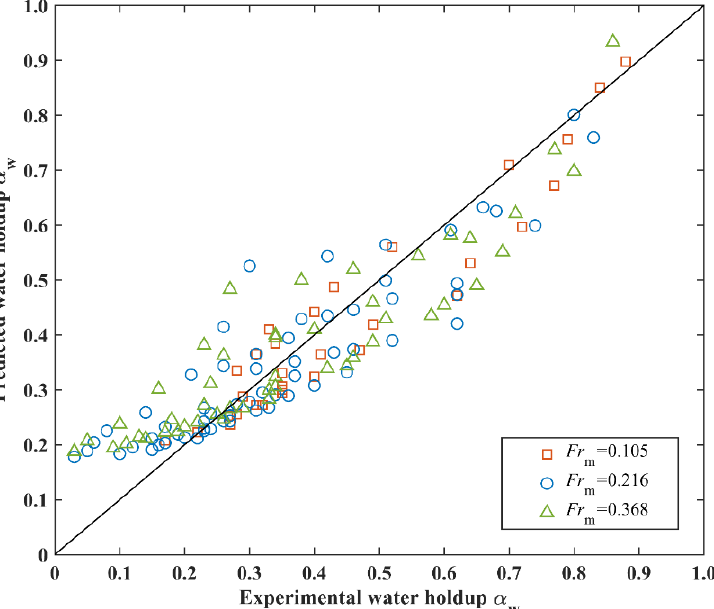
Figure 12. Comparison between the predicted water holdup and the experimental data for the oil – water – gas three-phase flow. The input water cut ε w ranged from 10% to 90%. The brown squares corresponded to Fr m = 0.105, the blue circles corresponded to Fr m = 0.216, and the green triangles corresponded to Fr m = 0.368.